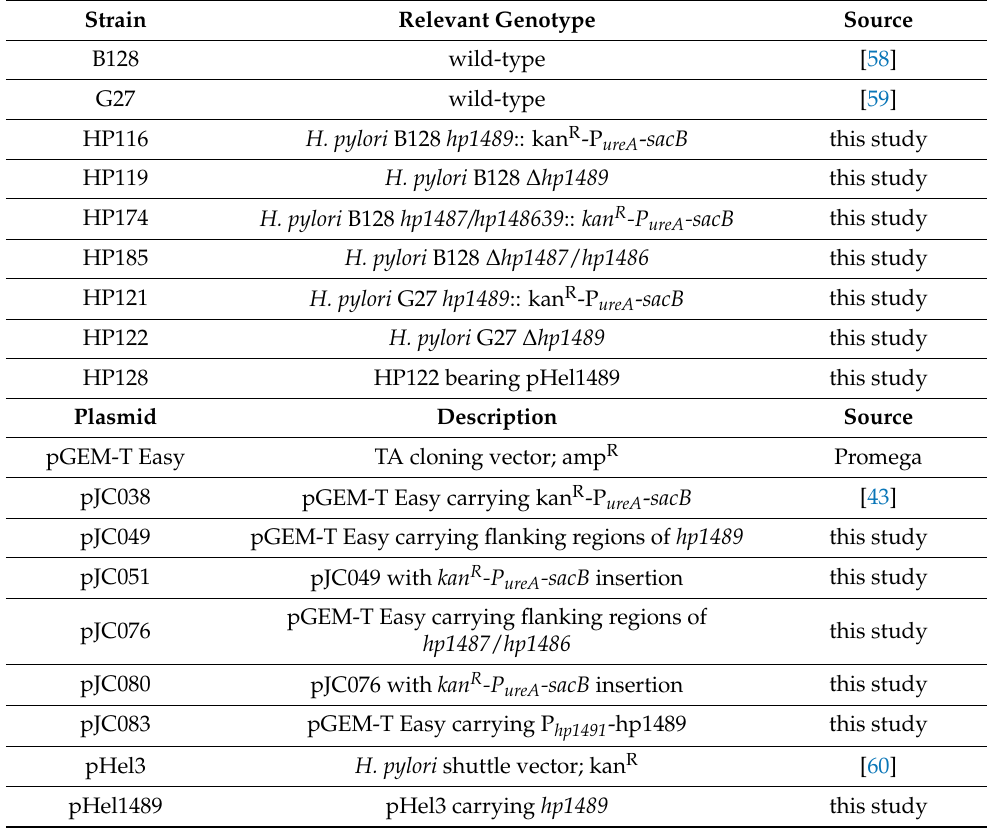
Table 4. H. pylori strains and plasmids used in this